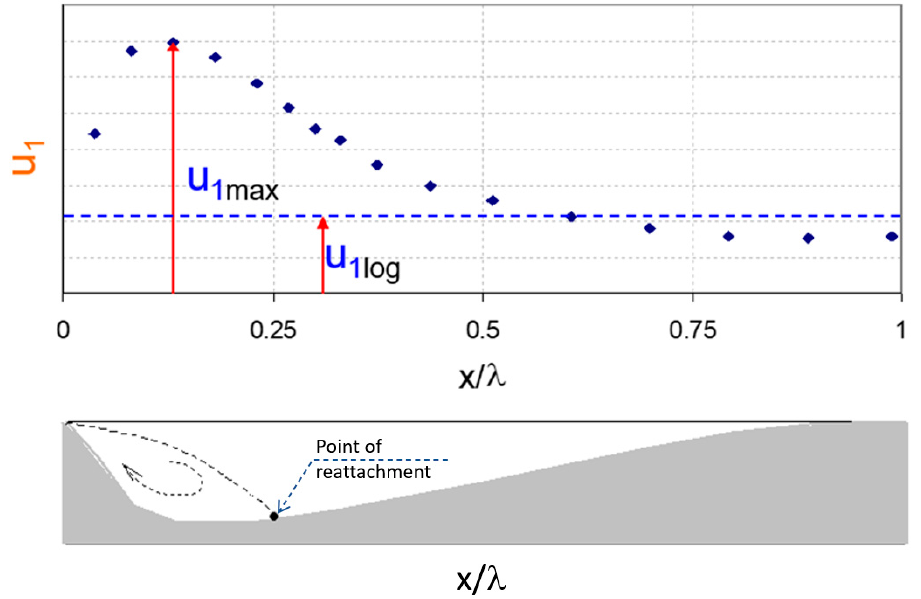
Figure 3. Typical spatial variation of u 1 above a bedform.